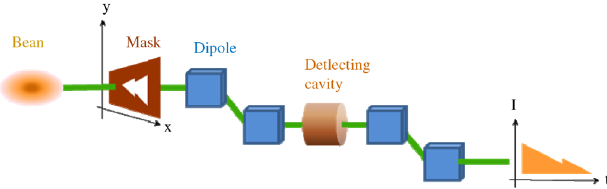
FIG. 3. Simplified sketch of a EEX beam line.